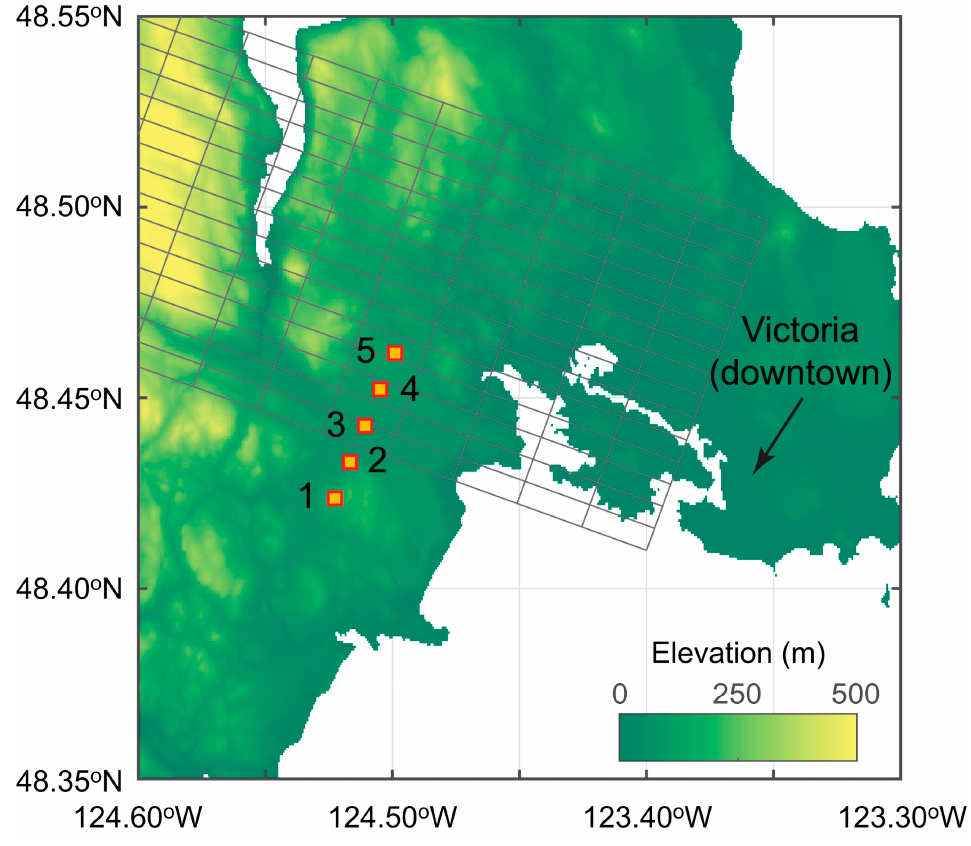
Figure 8. Locations of Sites 1 to 5 for the fault displacement hazard analysis of the Leech River Valley Fault.